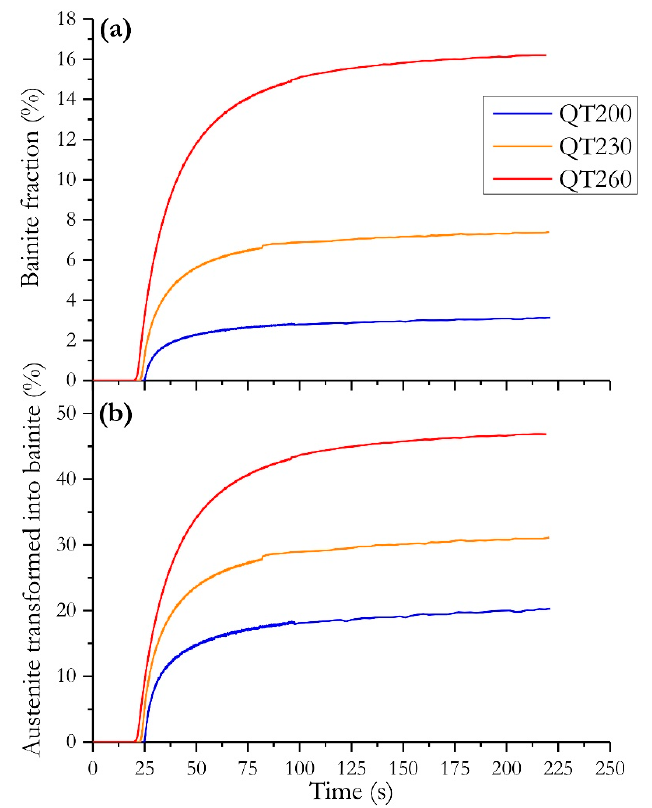
Figure 6. Evolution of ( a ) the new body-centered tetragonal (BCT) fraction and ( b ) amount of austenite transformed into new BCT for the three QTs studied.